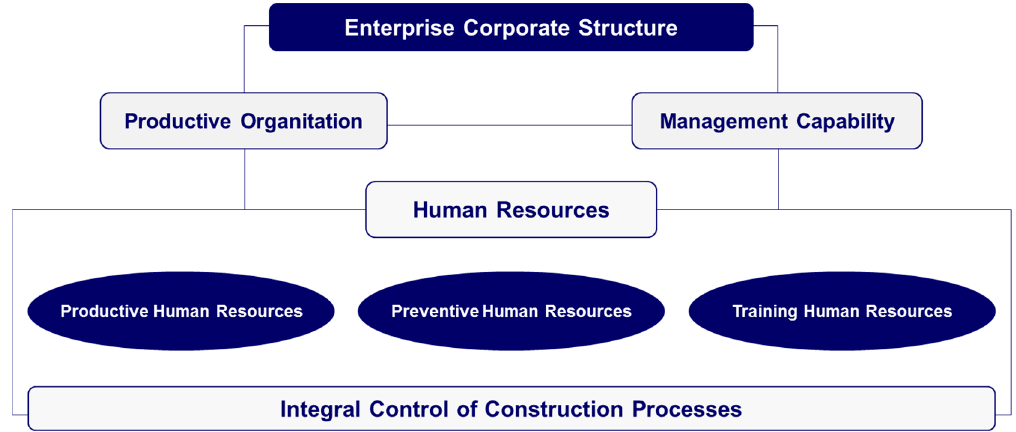
Figure 1. Requirements established in the REA for the accreditation of both the human and the material resources of subcontracting firms.